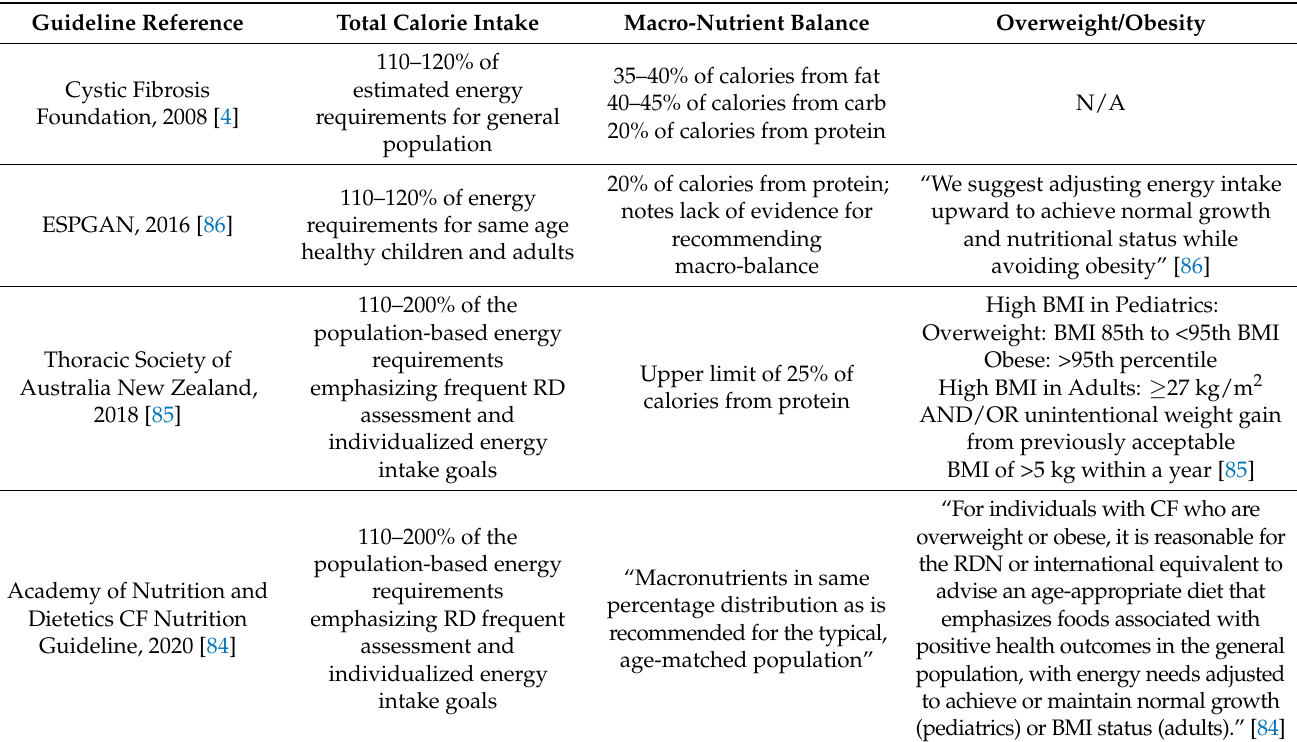
Table 2. Summary of cystic fibrosis nutrition